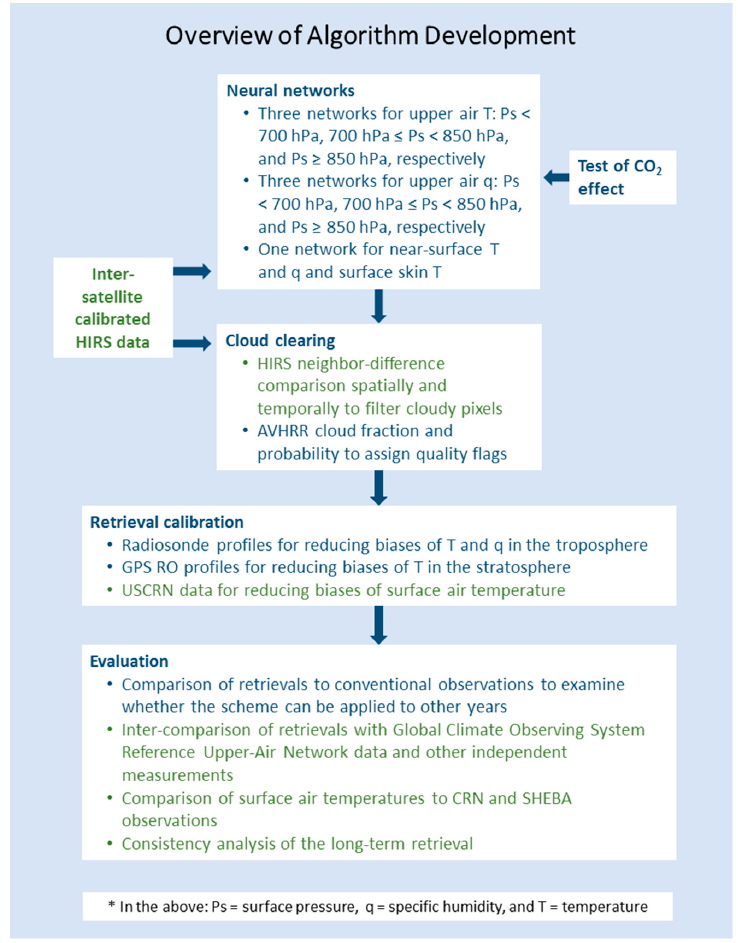
Figure 10. Overview of algorithm development. New developments in this study are listed in blue, and related developments outside of the study are in green.